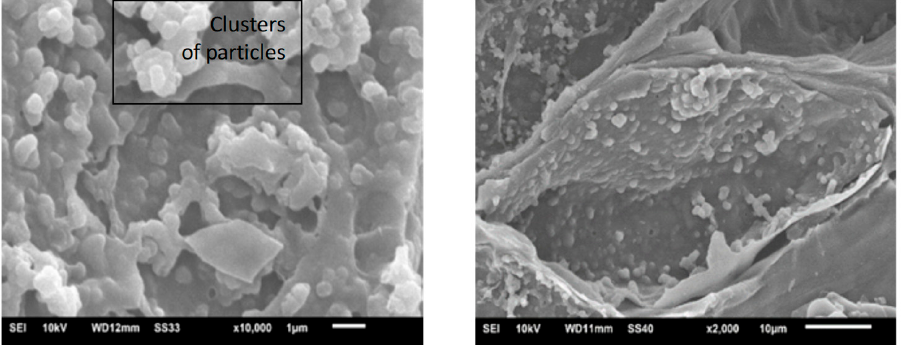
Figure 8. SEM image of PBc—Pb 2+ loaded (cluster particles).